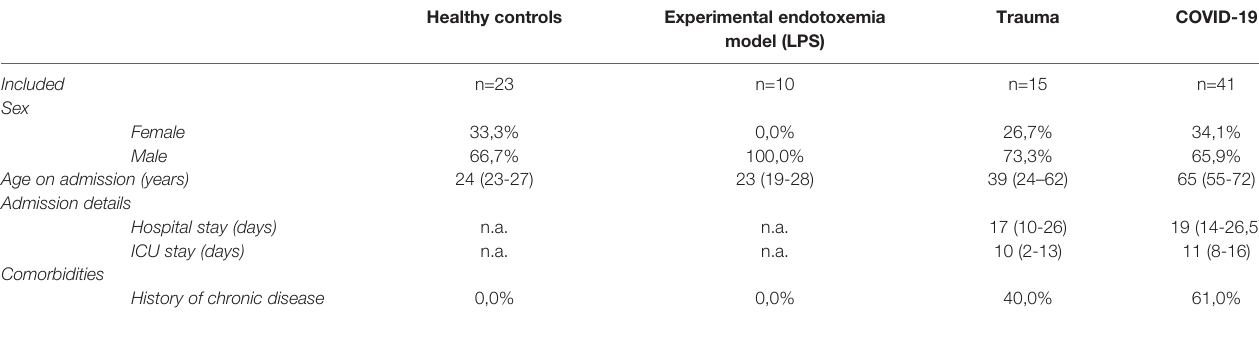
TABLE 1 | Baseline characteristics for each included cohort of subjects and patients. Values are presented as medians (IQR) or as percentages. Healthy